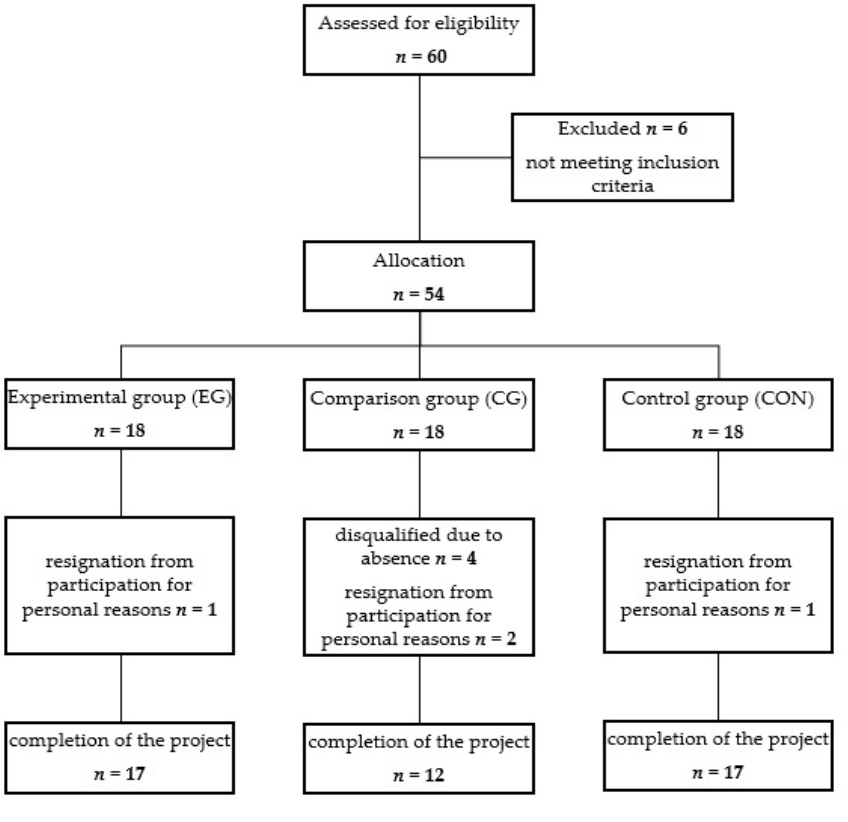
Figure 1. Study flow diagram.